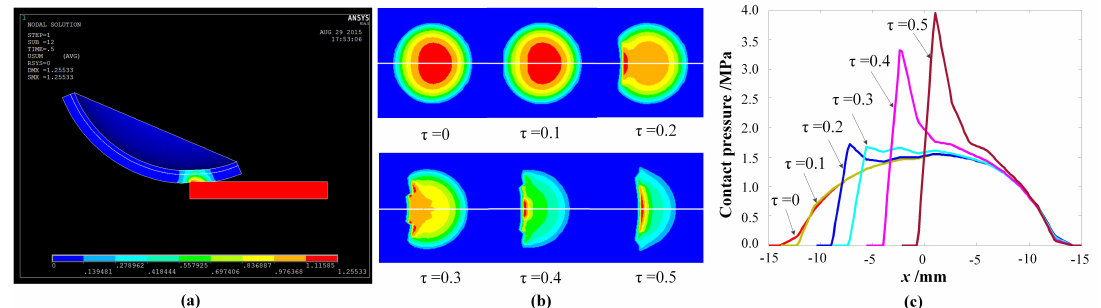
Figure 3. Finite element modeling of the contact pressure in the edge zone with different overhang ratio. ( a ) finite element model and corresponding displacement deformation result when τ = 0.5; ( b ) simulation results of the contact pressure distribution shape with different τ ; ( c ) sectional profile of the contact pressure along the white line plotted in ( b